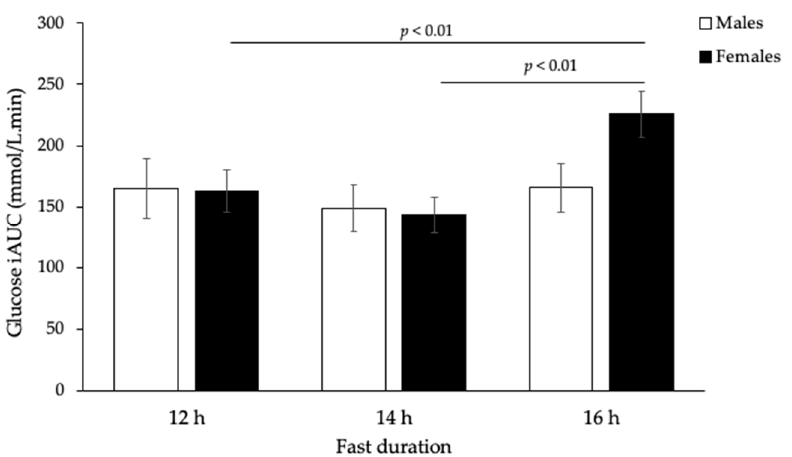
Figure 1. Mean (± SEM) changes in postprandial plasma glucose in ( a ) males ( n = 12) and ( b ) females ( n = 12) and postprandial plasma insulin responses in ( c ) males ( n = 12) and ( d ) females ( n = 12) to 75 g available carbohydrate standard breakfast at 12, 14, and 16 h fasting periods.